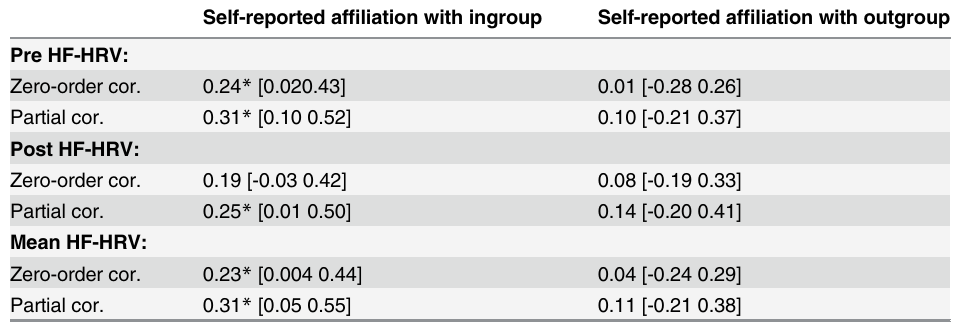
Table 2. The BCa bootstrapped estimates and 95% confidence intervals of zero-order and partial cor- relations of self-reported affiliation feelings towards the two groups with HRV variables. Self-reported af fi liation with ingroup Self-reported af fi liation with